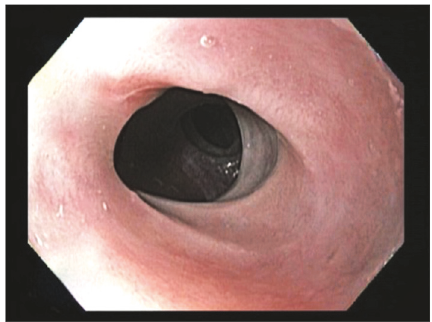
Figure 1: Stricture in the lower third of esophagus.